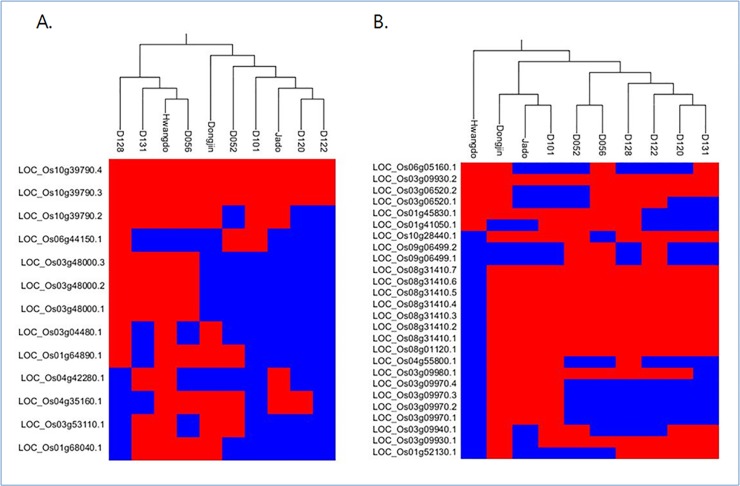
Hierarchical clustering of magnesium-transporter and sulfur-transporter genes among 10 rice accessions.For each rice accession, the reads were mapped to the reference genome, and the coding sequences of magnesium-transporter and sulfur-transporter genes were isolated. The red and blue colors represent normal or broken status (which induced a gap or frame shift in the CDS region), respectively. (a) Phylogenetic relationships among 13 anchored genes identified as magnesium transporters in the rice genome. (b) Phylogenetic relationships among 26 anchored genes identified as sulfur transporters in the rice genome.